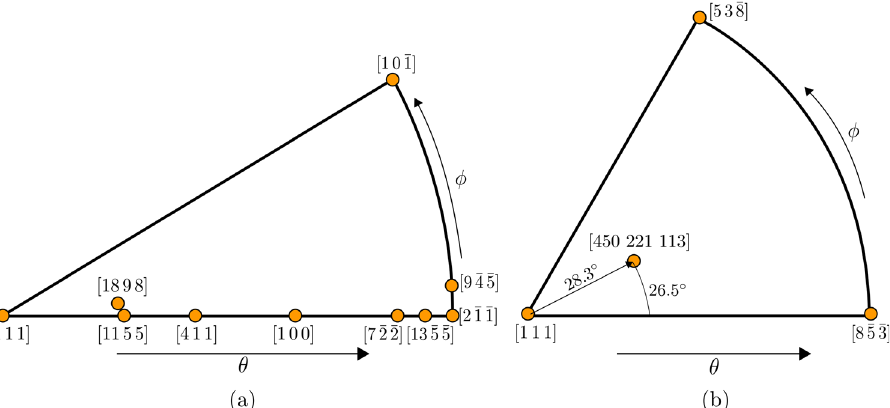
Fig. 6 The boundary-plane fundamental zones of a Σ 3 and b Σ 49 a misorientations are illustrated. The GBs analyzed in this article are highlighted and the indices of the boundary-plane normal vectors are provided